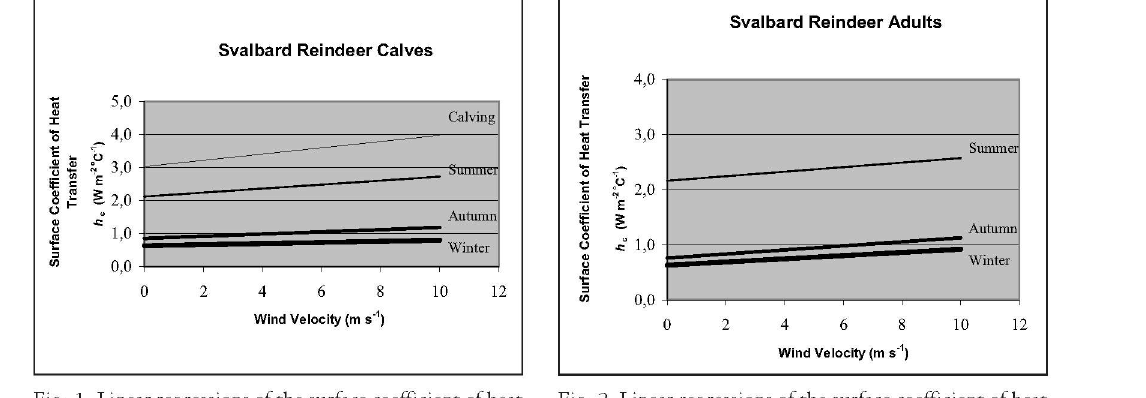
Fig. 2. Linear regressions of the surface coefficient of heat transfer on increasing wind velocity for Svalbard reindeer